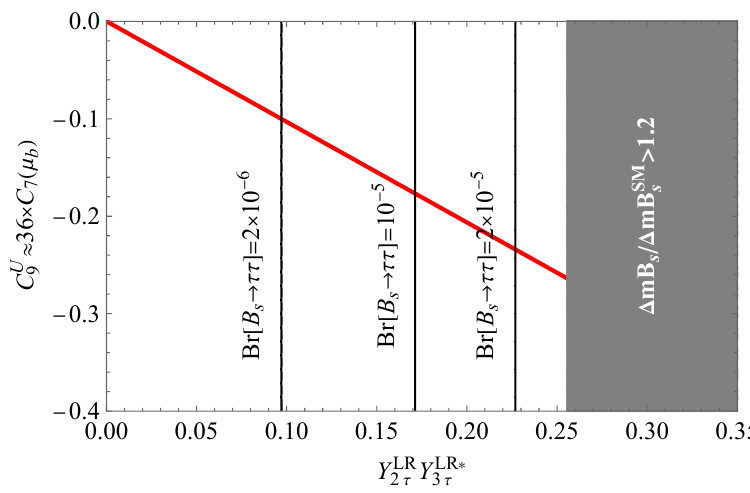
for M = 1 . 7 TeV. The contour lines Y LR ∗ τ 2 τ 3 τ + τ − branching ratio, and in the grey region the effect in s → τ